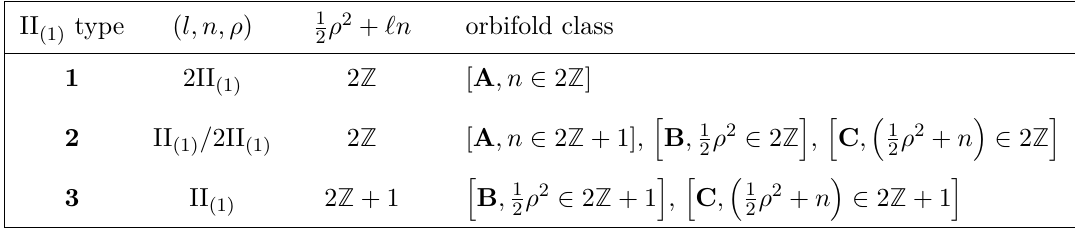
Table 9 . Points in II